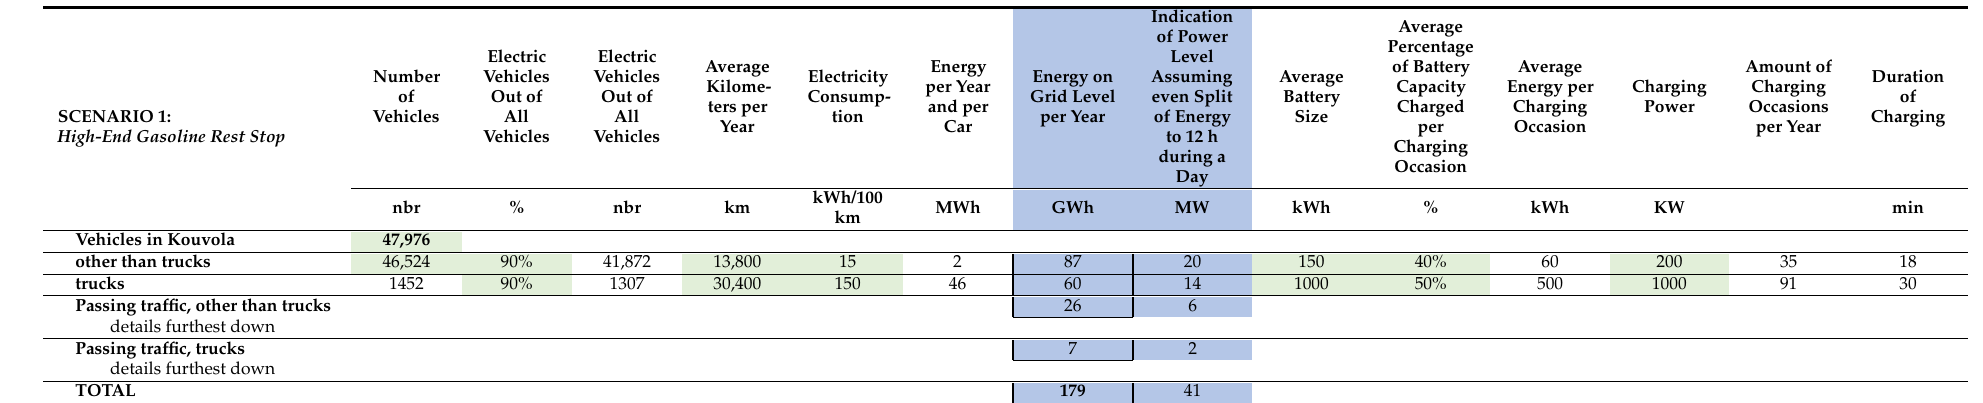
Table A1. Summary of Kouvola-based and passing traffic (including detailed quantification of the Kouvola-based traffic). Blue cells indicate results and green input